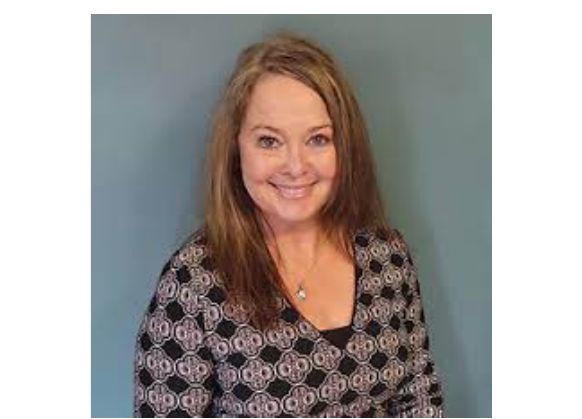
Figure 1 . Dr. Taryn S. Van Gilder-Pierce’s professional picture provided by her practice.